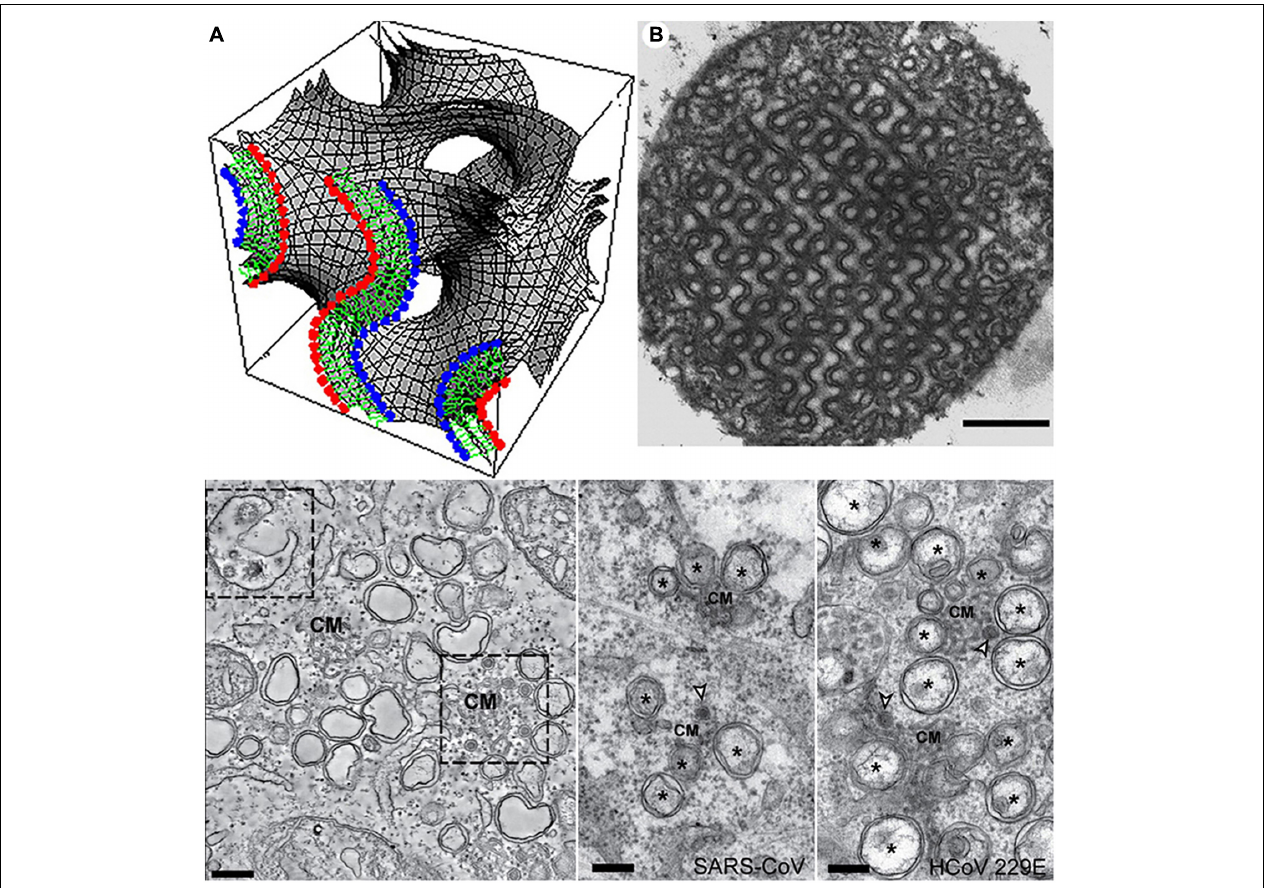
FIGURE 3 | Top panel: Cubic membrane topology represented by a mathematical model of the lipid bilayer organized on a 3D cubic lattice (A) and 2D-projected transmission electron microscopy (TEM) image of cubic membranes found in the mitochondria of 10-day starved ameba Chaos cells (B) . Scale bar: 500 nm. Reprinted from Deng and Almsherqi (2015) with permission. Bottom panel: TEM images of interconnected convoluted membrane structures (CM) induced by MERS-CoV infection in mammal Huh7 cells (left) and SARS-CoV and HCoV-229E coronavirus induced convoluted membranes (CM), double-membrane vesicles (DMV), and double-membrane spherules (middle and right). Scale bars: 250 nm. Reprinted from Snijder et al. (2020) with